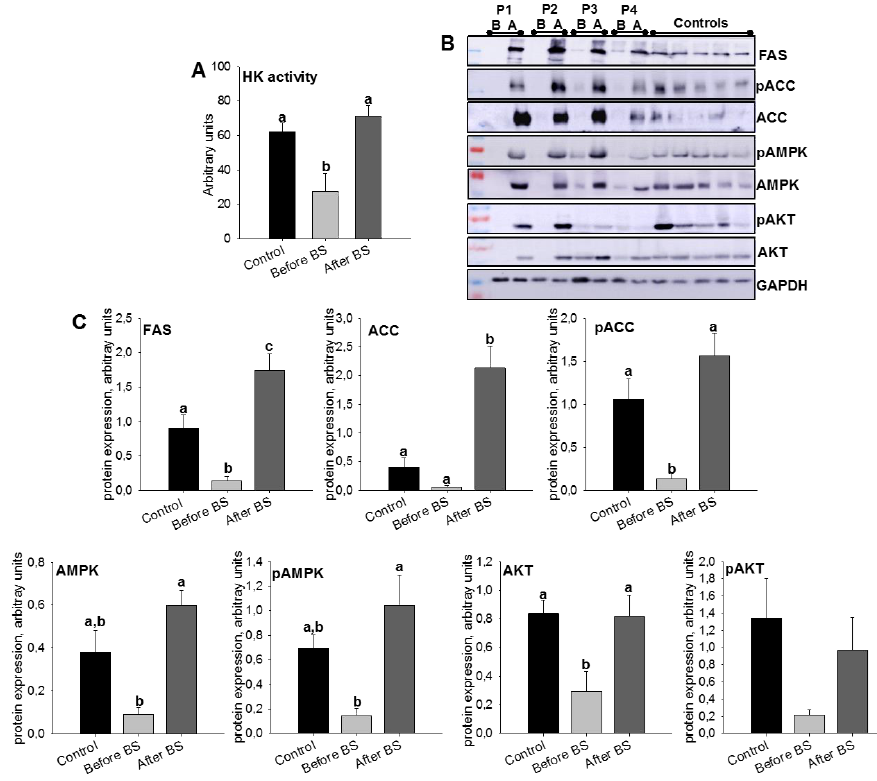
Figure 4. aSAT hexokinase (HK) activity levels ( A ) and protein expression levels ( B , C ) of lipid metabolism and insulin signaling-related enzymes, in control patients and obese patients before BS and the same patients after BS. Values are means ± SEM of six patients per group (HK activity) or 4–5 patients per group (Western blot). Di ff erent letters above the bars indicate statistically significant di ff erences, p < 0.05. P.1–P.4 = Patient 1–Patient 4. B = before bariatric surgery, A = after bariatric surgery. Controls = healthy patients with normal BMI. BS = bariatric